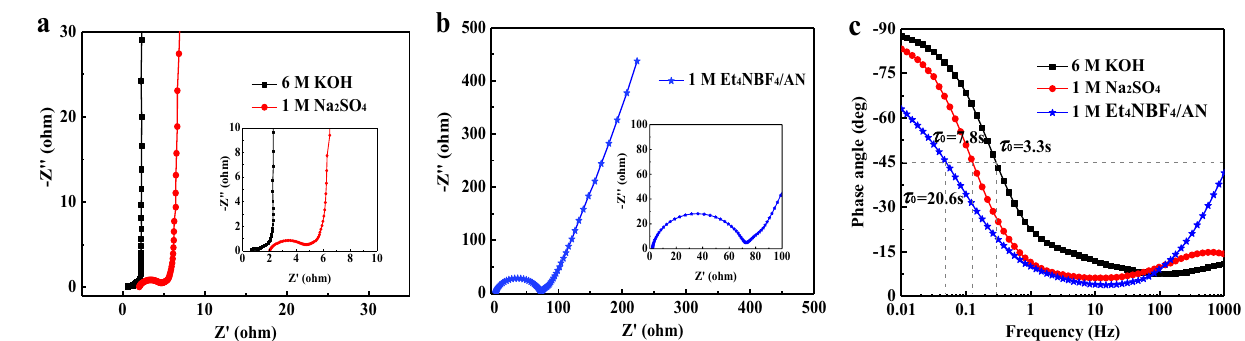
Figure 7. Electrochemical characteristics of HPGC-750 symmetric supercapacitor: ( a ) CV curves at various scan rates in 6 M KOH; ( b ) GCD curves at various current densities in 6 M KOH; ( c ) CV curves tested in different potential windows at 40 mV s −1 in 1 M Na 2 SO 4 ; ( d ) CV curves at different scan rates in a potential window of 1.8 V in 1 M Na 2 SO 4 ; ( e ) GCD curves at different current densities in 1 M Na 2 SO 4 ; ( f ) Ragone plots of HPGC-750//HPGC-750 supercapacitor and performances comparison with other carbon-based symmetric supercapacitors (circle: 6 M KOH electrolyte, and sphere: 1 M Na 2 SO 4 electrolyte).